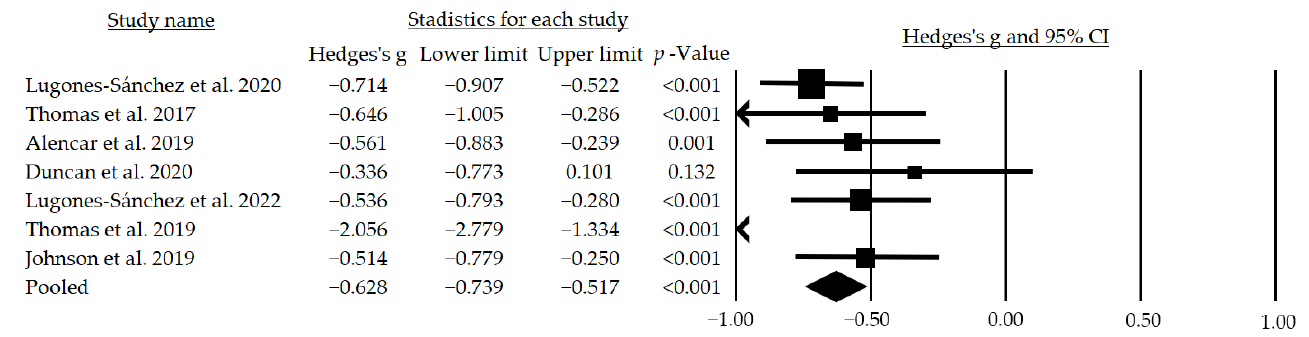
Figure 5. Effects of telemedicine over the body weight in people with overweight. The black box represents the point estimate for the respective study, while the size of the box represents the population size and the horizontal line is the 95% CI. The diamond-shaped figure represents the estimated point of the mean effect size. The arrow represents that the point estimate for this study is less than − 1.00 [38–44].